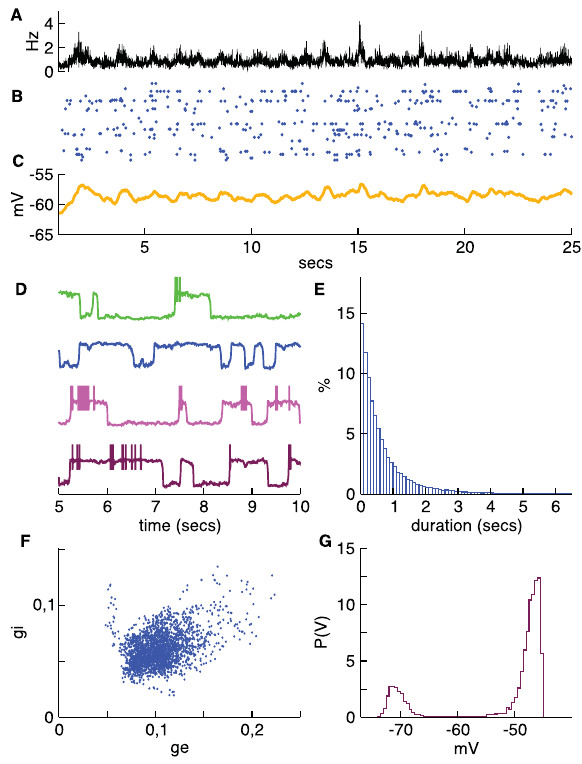
Figure 6. A more irregular network II . Same as Figure 5 , but now the expanded box and panels B–E show the last five seconds of the simulation. Four up-state transitions occur during this time.